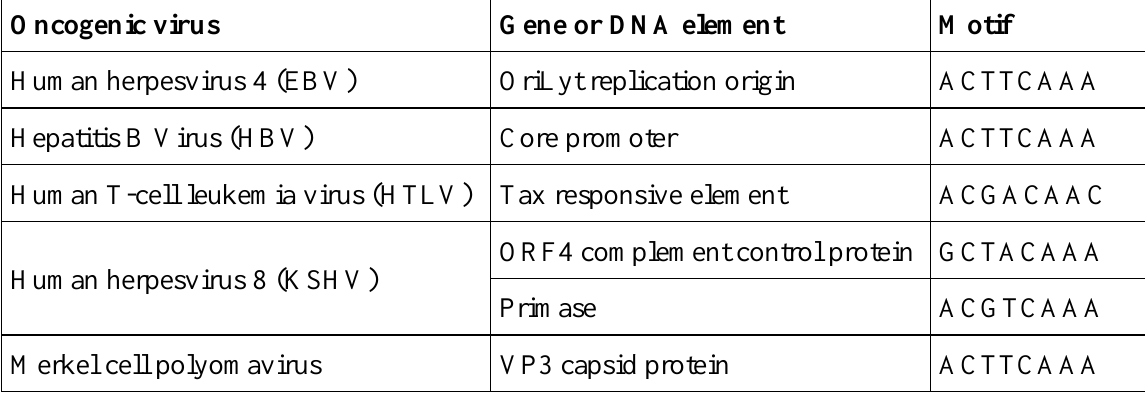
Table 3. PARP1 binding motifs identified in oncogenic viral